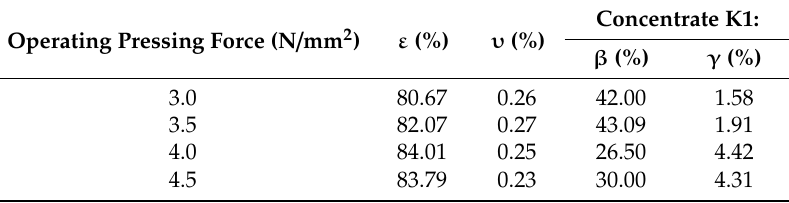
Table 6. Results of flotation on HRC crushing